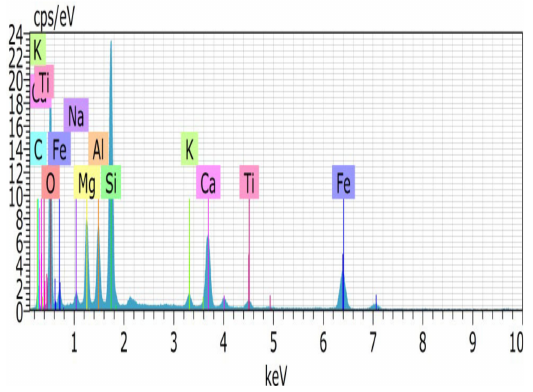
Figure 2. EDAX images of